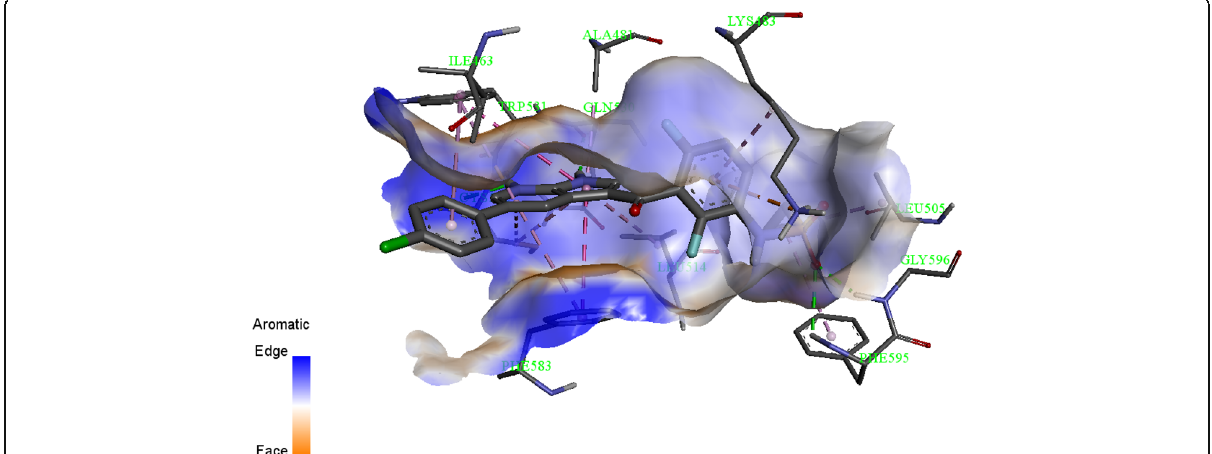
Fig. 9 3D diagram of the interaction between vemurafenib with